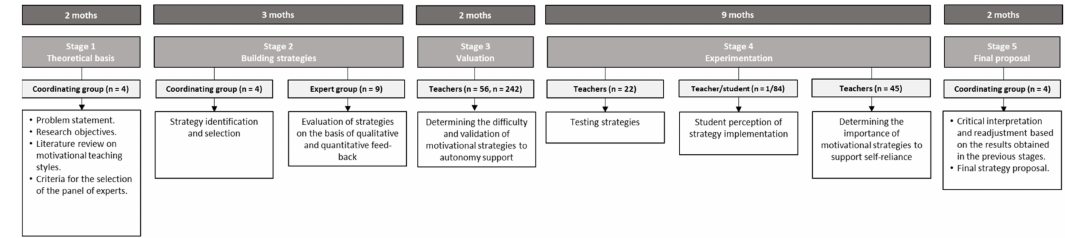
Figure A1. Stages and phases of the strategy measurement model.